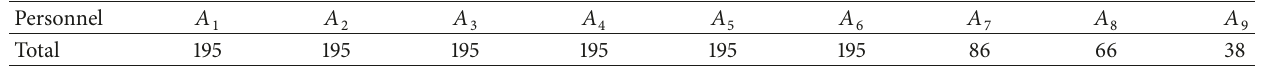
Table 4: Number of working time periods of each window employee in two